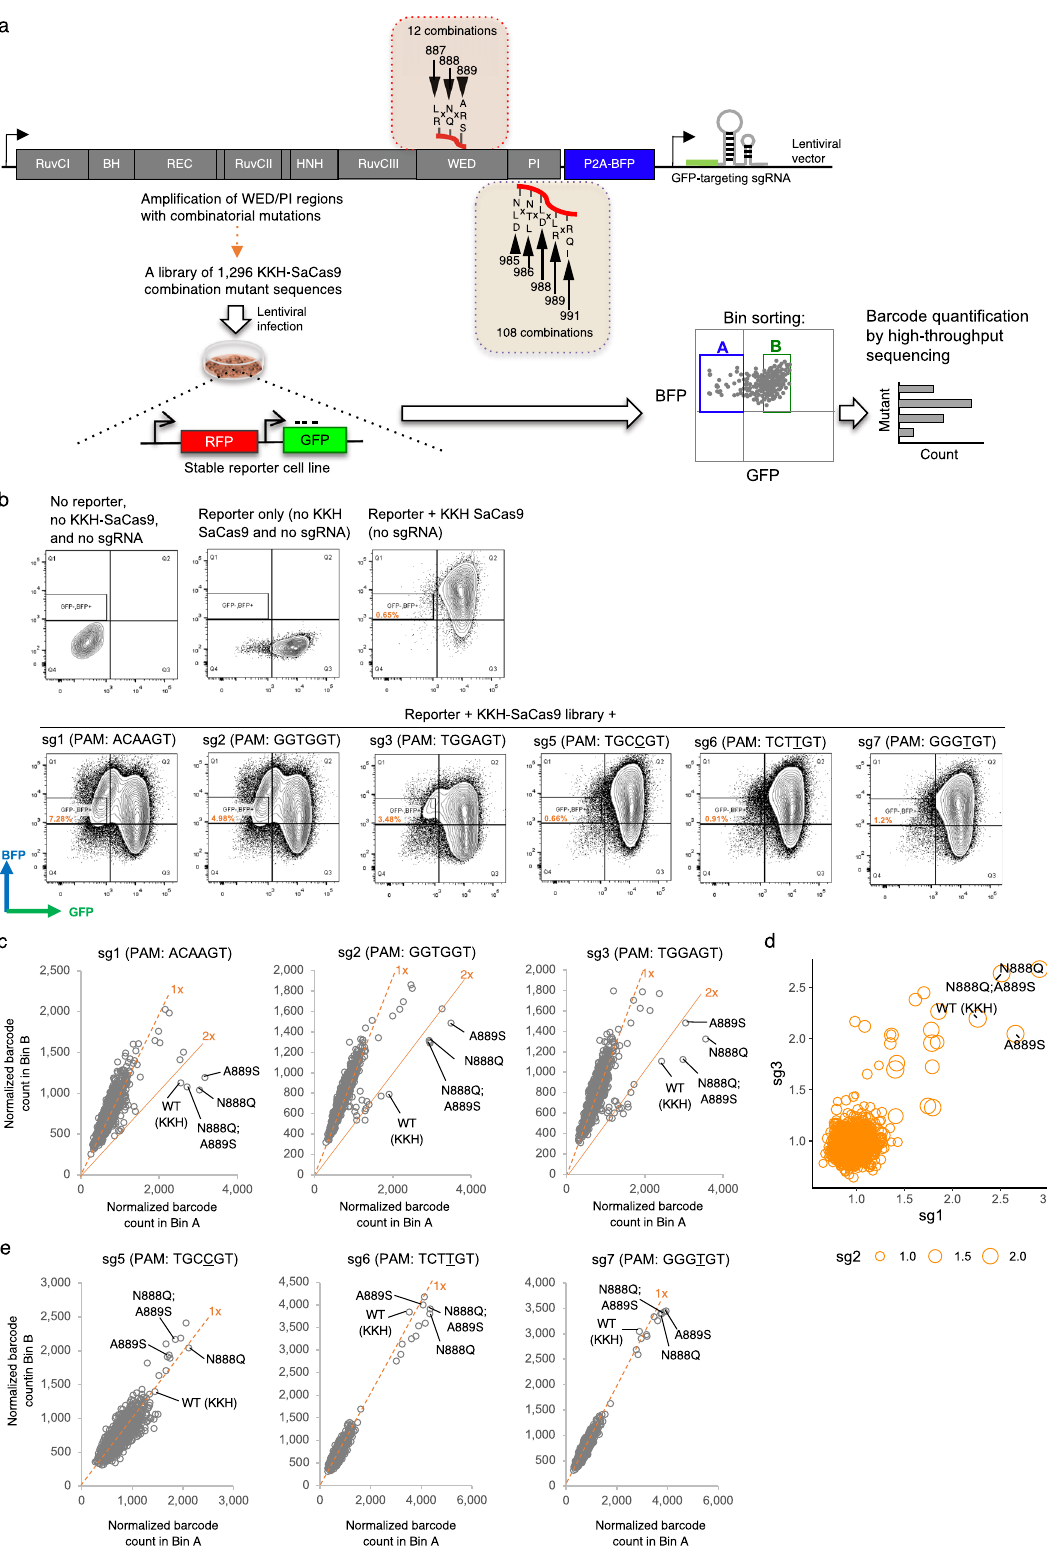
four more combined mutation variants (i.e., N888H/A889Q, N888S/A889Q, N888R/A889Q, and N888H/A889N) on those positions, which were selected based on predicted contact gains with the PI domain via N986, D987, L988, and/or L989 (Fig. 4a; Supplementary Fig. 13). Among the variants tested, the one harboring N888R/A889Q mutations (hereafter designated as